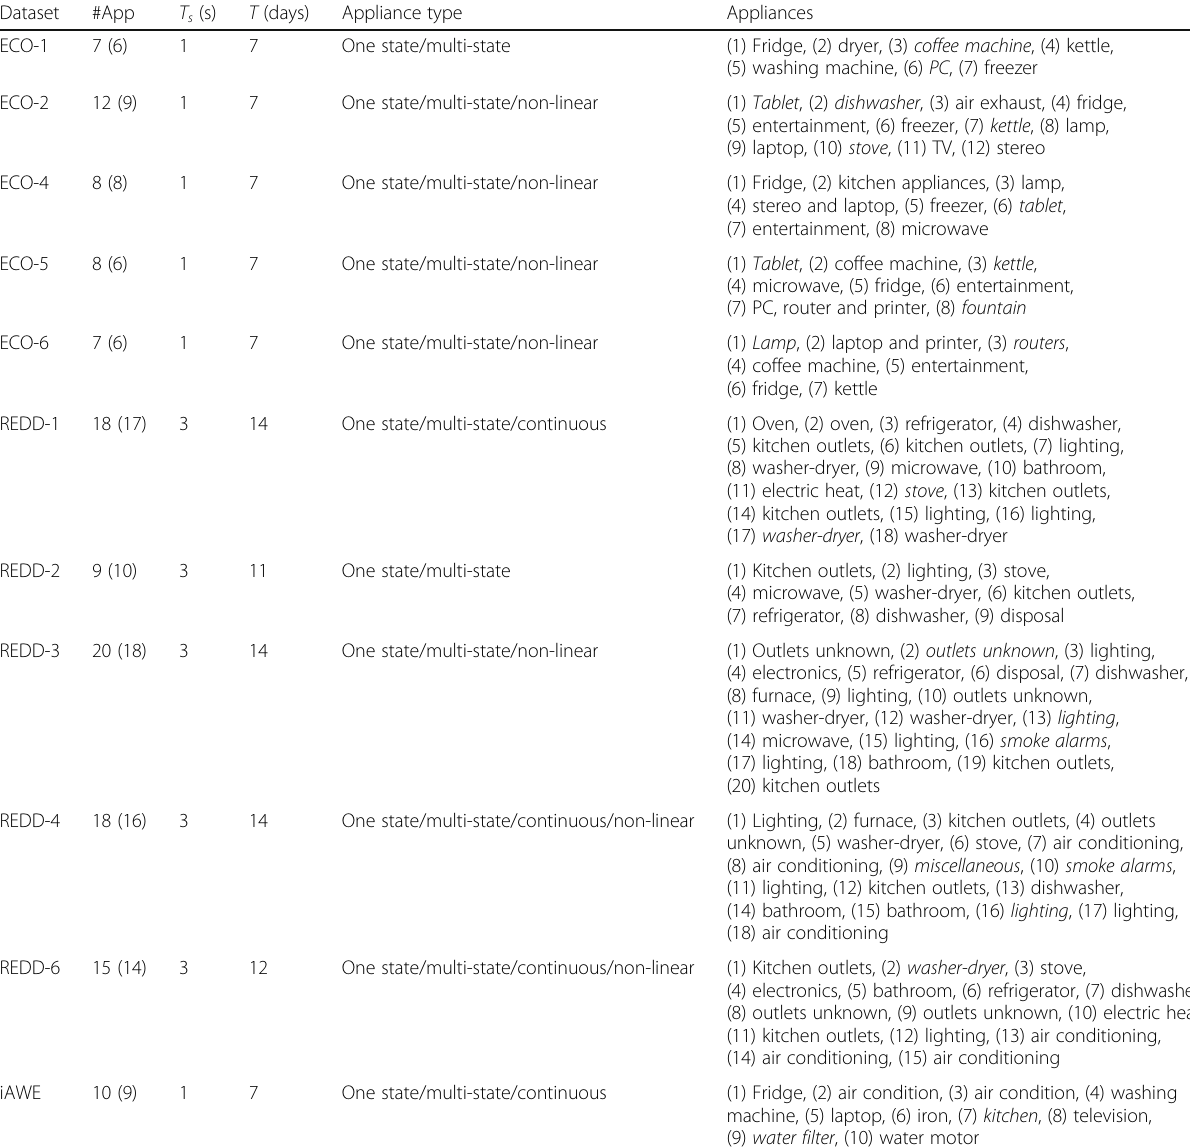
Table 1 List of evaluated datasets and their properties